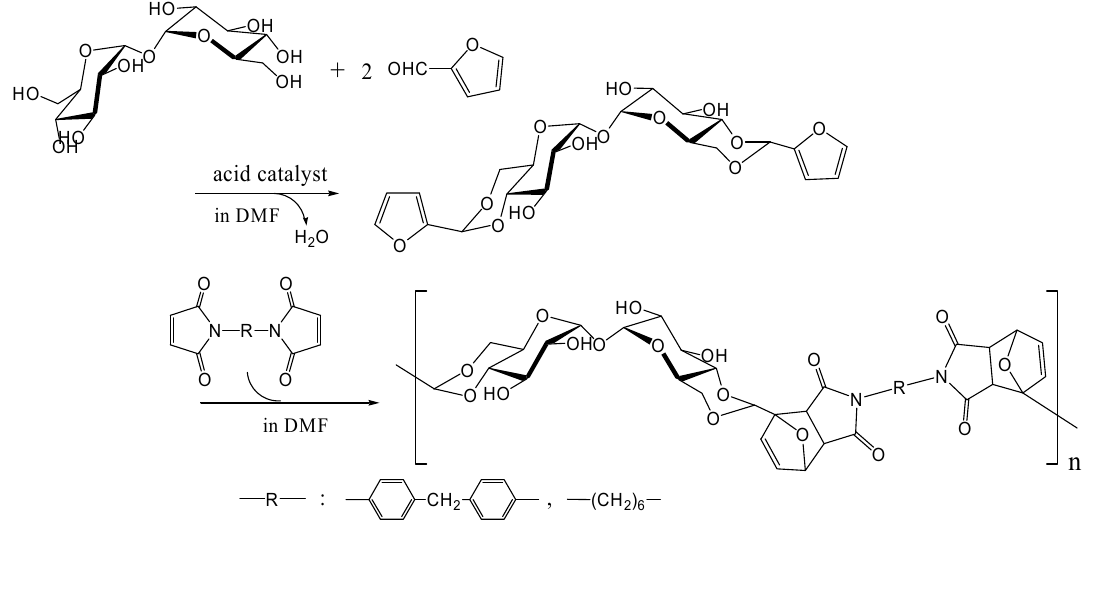
Figure 18. Synthesis of trehalose-based polymer by the Diels-Alder